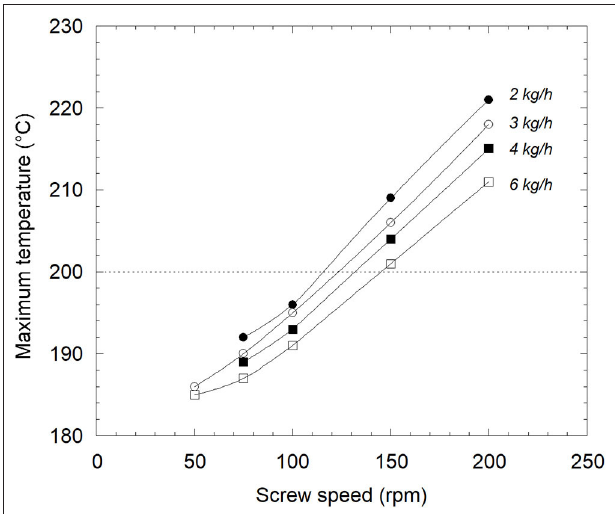
FIGURE 3 | Changes in maximum temperature with screw speed for different feed